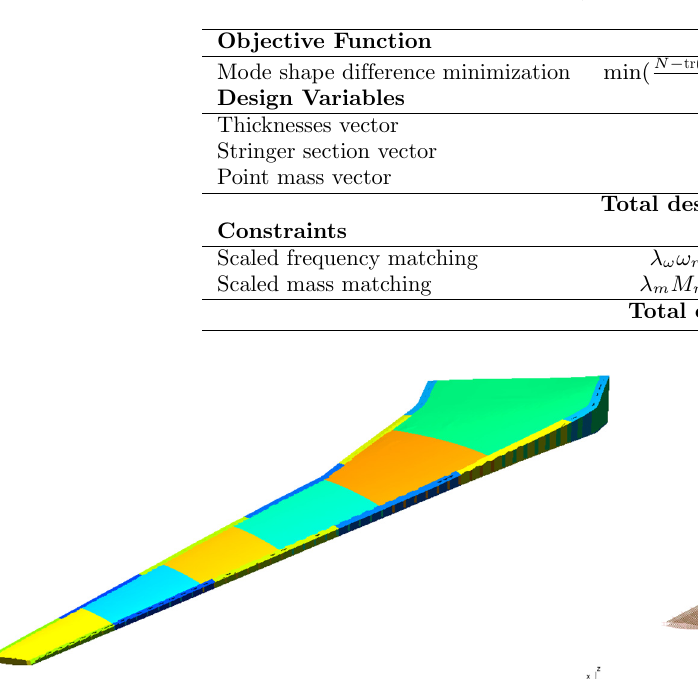
Table 1. Modal optimization problem for structural dynamic scaling.